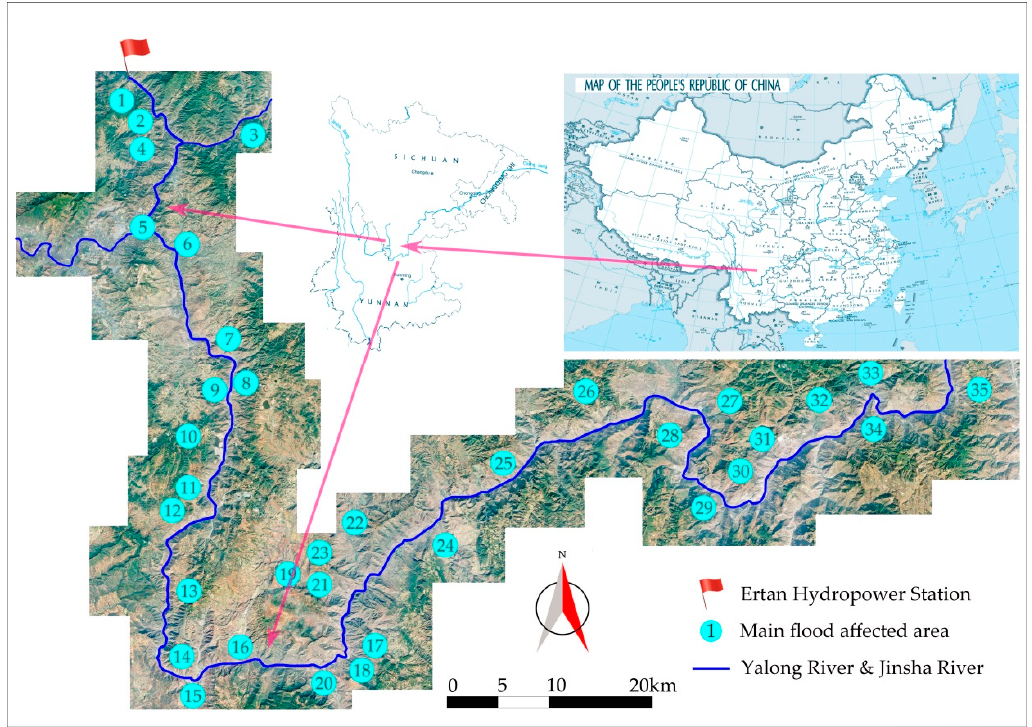
Figure 1. Main flood-affected areas.